Question: What type of chart is this?
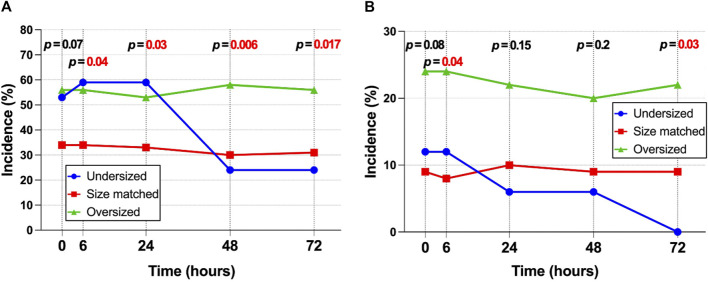
Answer: line